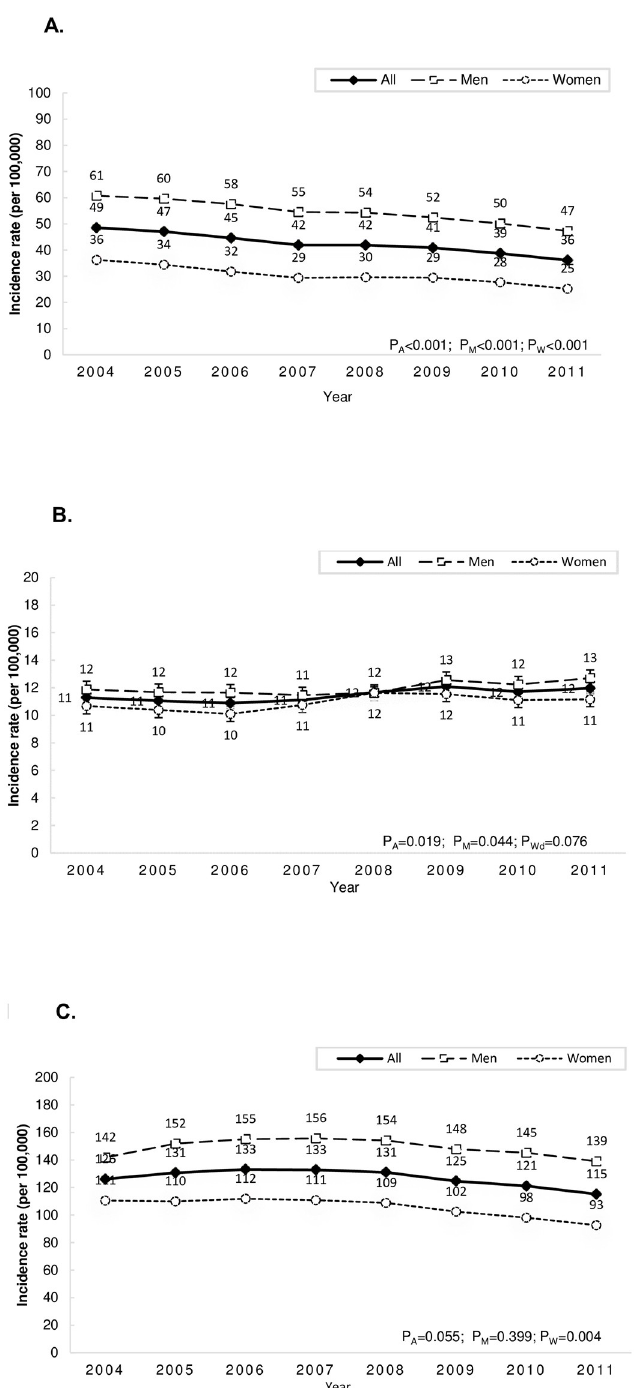
Fig 2. A . Trends of incidence of intracerebral hemorrhage. B . Trends of incidence of subarachnoid hemorrhage. C . Trends of incidence of ischemic stroke. P All = p for trend in all strokes; P M = p for trend in men; P W = p for trend in